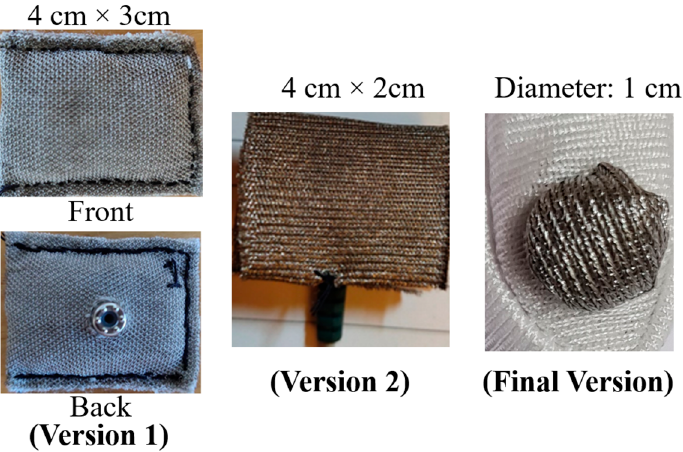
Figure 4. Investigation of textile electrodes of different shape and size.